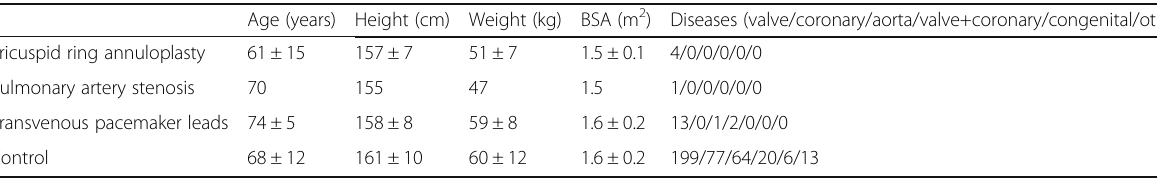
Table 1 Patients ’ characteristics in each category